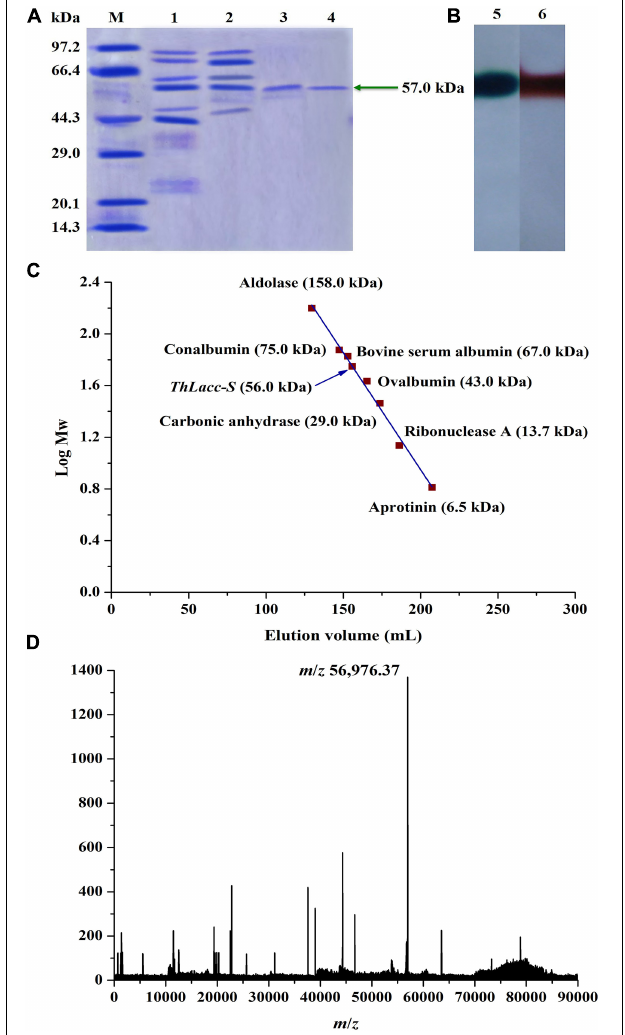
FIGURE 1 | Molecular weight authentication of laccase ThLacc-S from Trametes hirsuta . (A) SDS-PAGE consisting of a 12% (w/V) separating gel